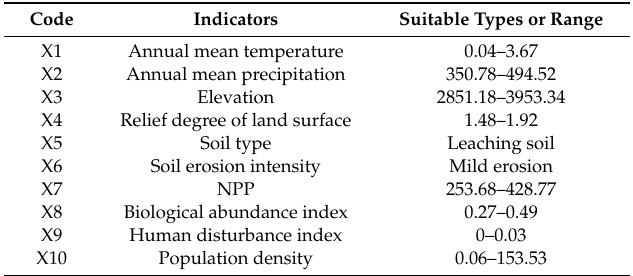
Table 7. Suitable limits of natural factors (95% confidence level).